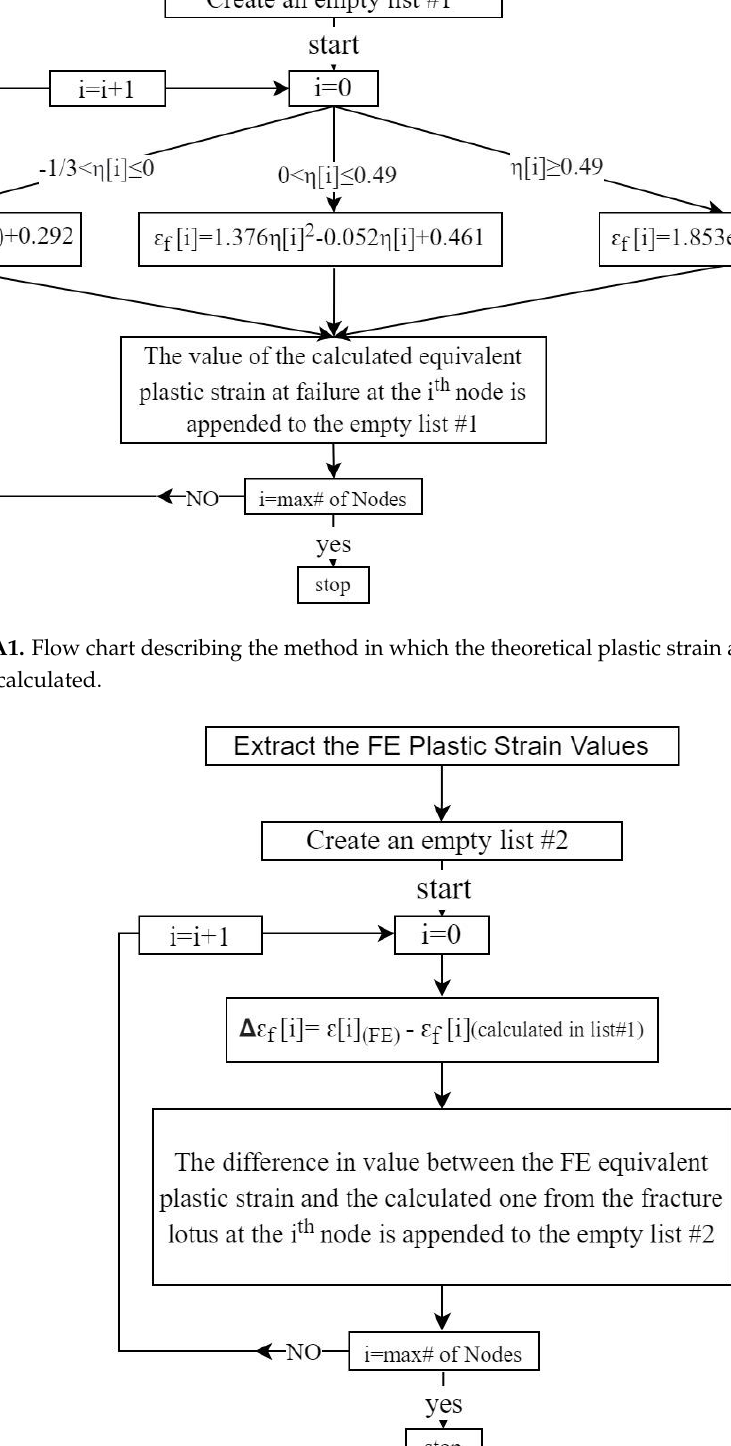
Figure A2. Flow chart describing the method used to identify the difference between the FE and the theoretical equivalent plastic strain.